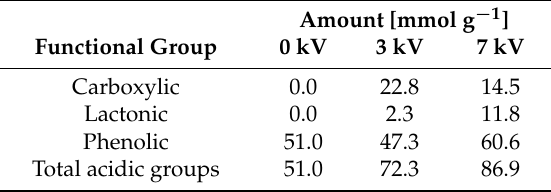
Table 6. Functional groups determined by titration.